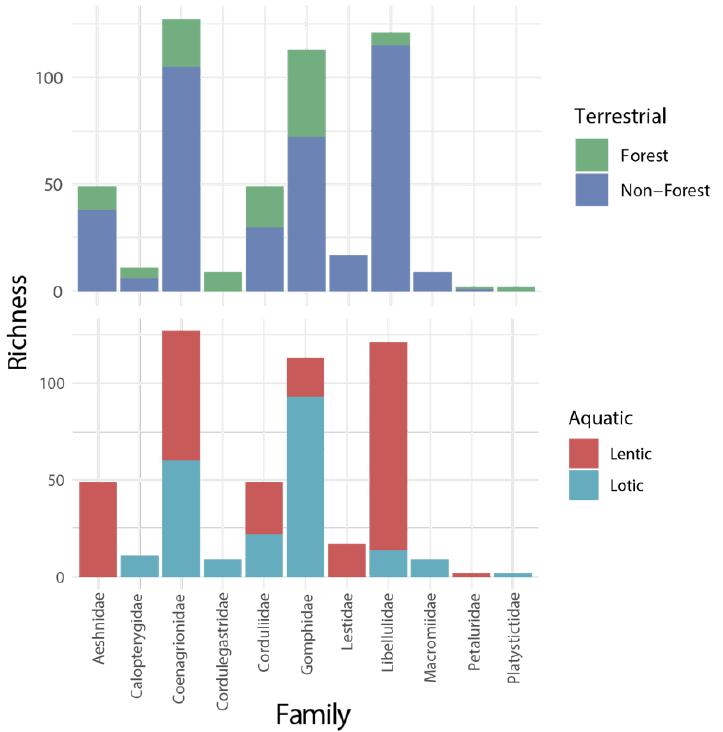
Figure 5. Species richness by family for forest- and non-forest-dependent species (above) and lentic- and lotic-dependent species (below).